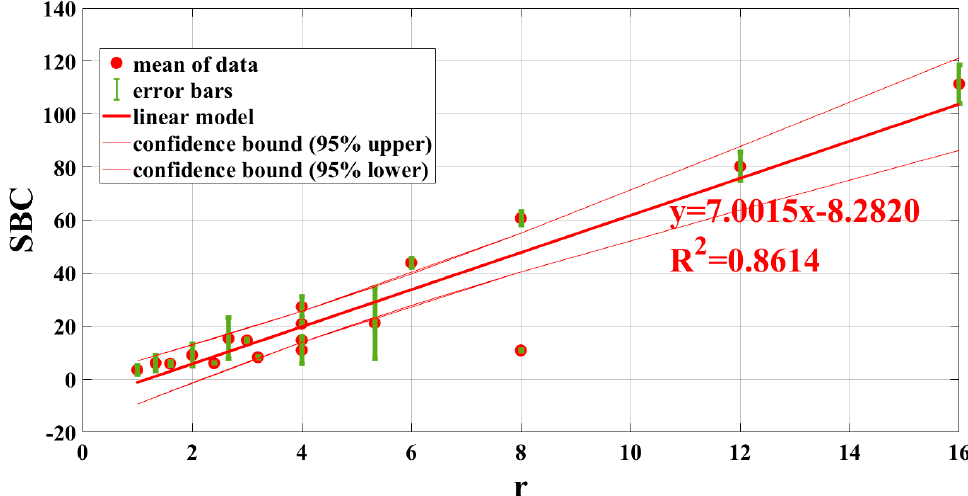
Figure 13. SBC versus r for TSR 1st derivative 1024 frames, error bars and confidence bounds on the find linear model.